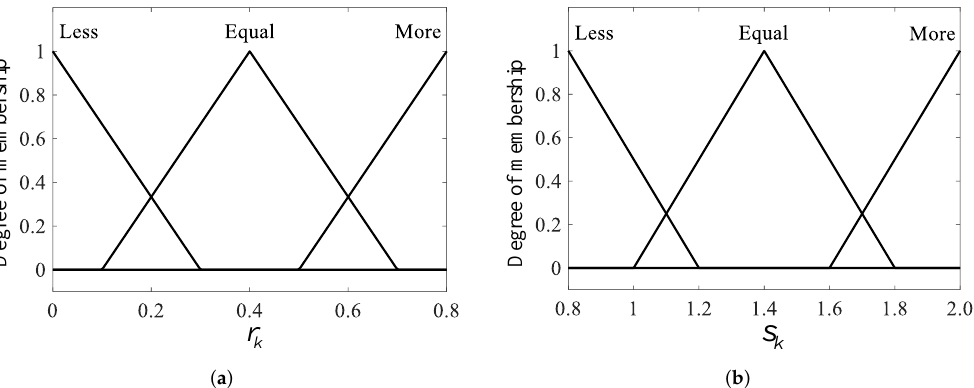
Figure 4. The membership function of input and output. ( a ) The input of fuzzy inference system. ( b ) The output of fuzzy inference